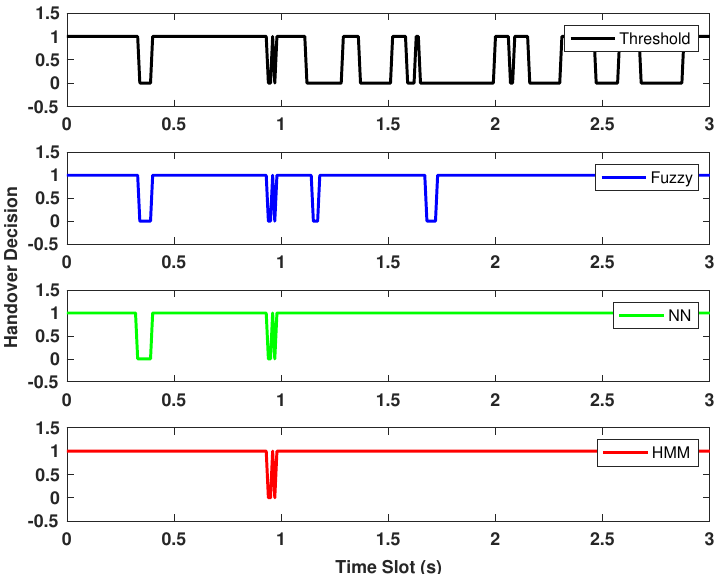
Figure 6. Handover decision comparison for proposed HMM, Fuzzy, NN, Threshold